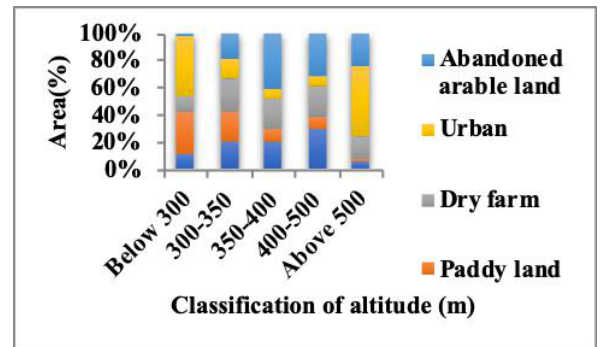
Figure 9 The distribution of forest, paddy field, dry farm, urban and abandoned arable land in different elevation